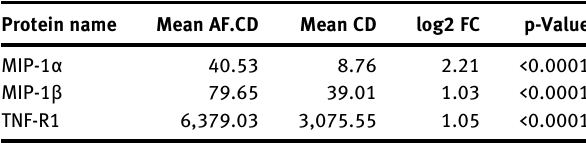
Table  : Differential expressed serum proteins between  anal fi stulas with CD and  CD only samples detected by antibody